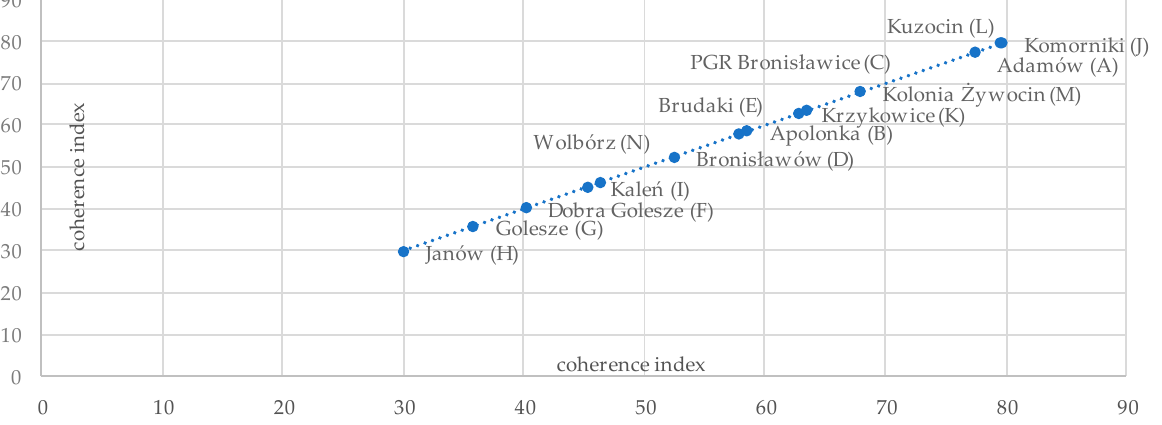
Figure 8. The ranking of objects with respect to the cadastral data coherence with primary data. Source: own study.